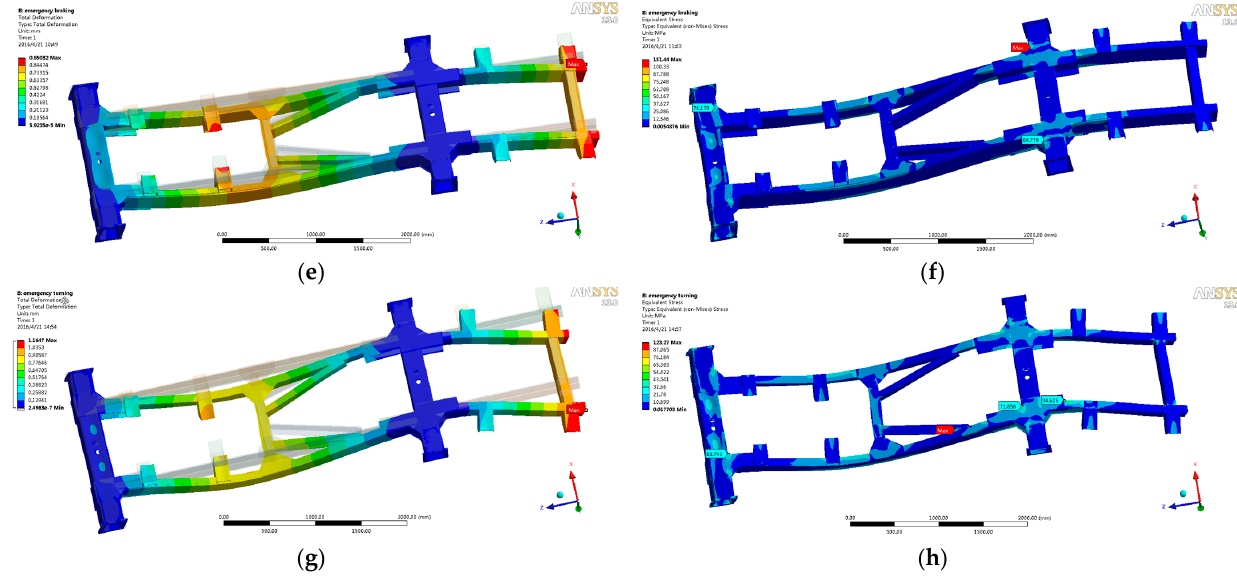
Figure 9. Finite element analysis results of the frame for each working condition. ( a ) Frame strain distribution in bending conditions; ( b ) Bending condition frame stress distribution diagram; ( c ) Frame strain distribution for torsional conditions; ( d ) Torsional conditions frame stress distribution diagram; ( e ) Emergency braking conditions frame strain distribution; ( f ) Emergency braking condition frame stress distribution diagram; ( g ) Frame strain distribution for emergency turning conditions; ( h ) Frame stress distribution in emergency turning conditions.